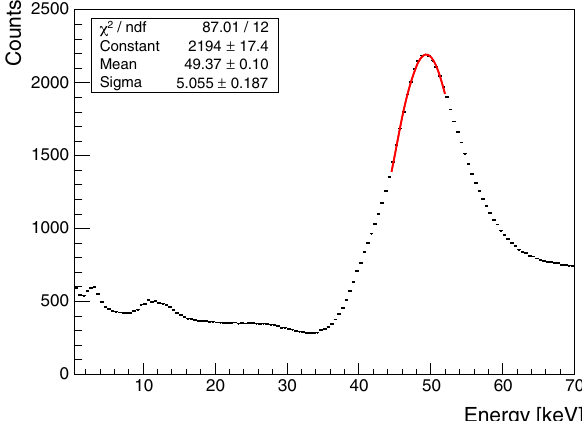
Fig. 4 Gaussian fit to the 210 Pb peak in the Monte Carlo simulated spectrum of crystal NaI-33. The position of this peak, calculated by the fit, is used to evaluate the energy correction factor to be applied in real